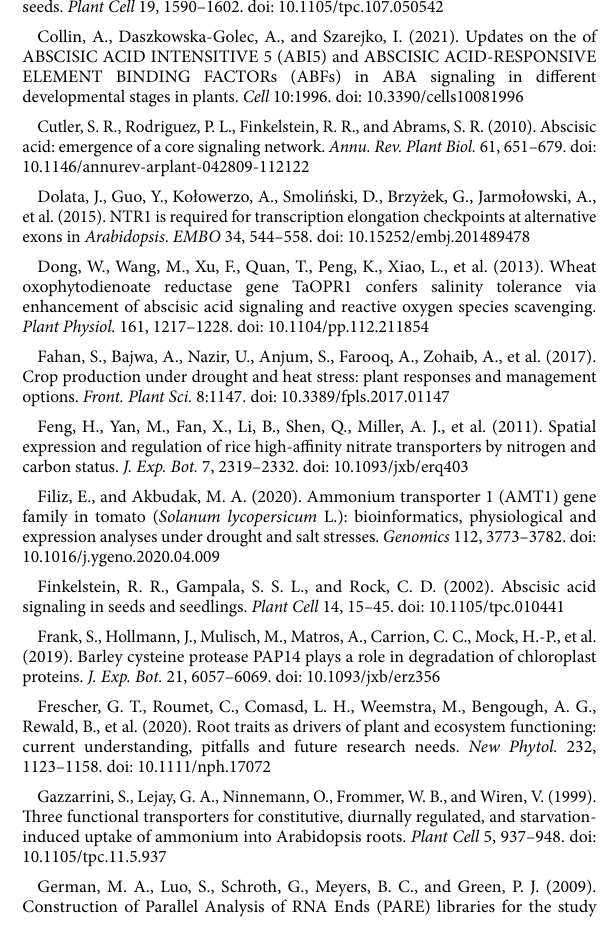
transcription start site. Grey arrows show the location of primers flanking the CArG motifs. Graphs depict ChIP-qPCR results from roots of mads27 c-Myc OE plants in control and excess N stress, using primers flanking CArG motifs. We observe no accumulation of HvMADS27 on analyzed promoters. No Atb-ChIP qPCR with no added anti-myc antibody or WT wild-type plants SUPPLEMENTARY FIGURE S10 Expression pattern of HvSCR, HvABI4 genes. (A) RT-qPCR result showing HvSCR mRNA level in WT and mutants under control and high soil N conditions, where x-axis represents analyzed variants and y-axis represents expression level relative to ARF1 mRNA. There was no significant change in HvSCR expression in the mutants compared with WT plant. (B) RT-qPCR results showing HvABI4 mRNA level in WT and analyzed mutants in control and excess N conditions where x-axis presents analyzed variants and y-axis expression level relative to ARF 1 mRNA. Expression of HvABI4 is not changed in excess N stress in WT and mutants when compared to control conditions. SUPPLEMENTARY FIGURE S11 Number of lateral roots in WT and hvmads27 mutant plants. Number of lateral roots calculated based on scans of root systems of WT, mads27 kd and mads27 c-Myc OE mutants, where x-axis shows analyzed variants and y-axis number of observed lateral roots. In each case (WT, mads27 kd , mads27 c-Myc OE ) number of lateral roots was higher under high N stress. Statistical significance based on standard Student t -test is provided, ** p <